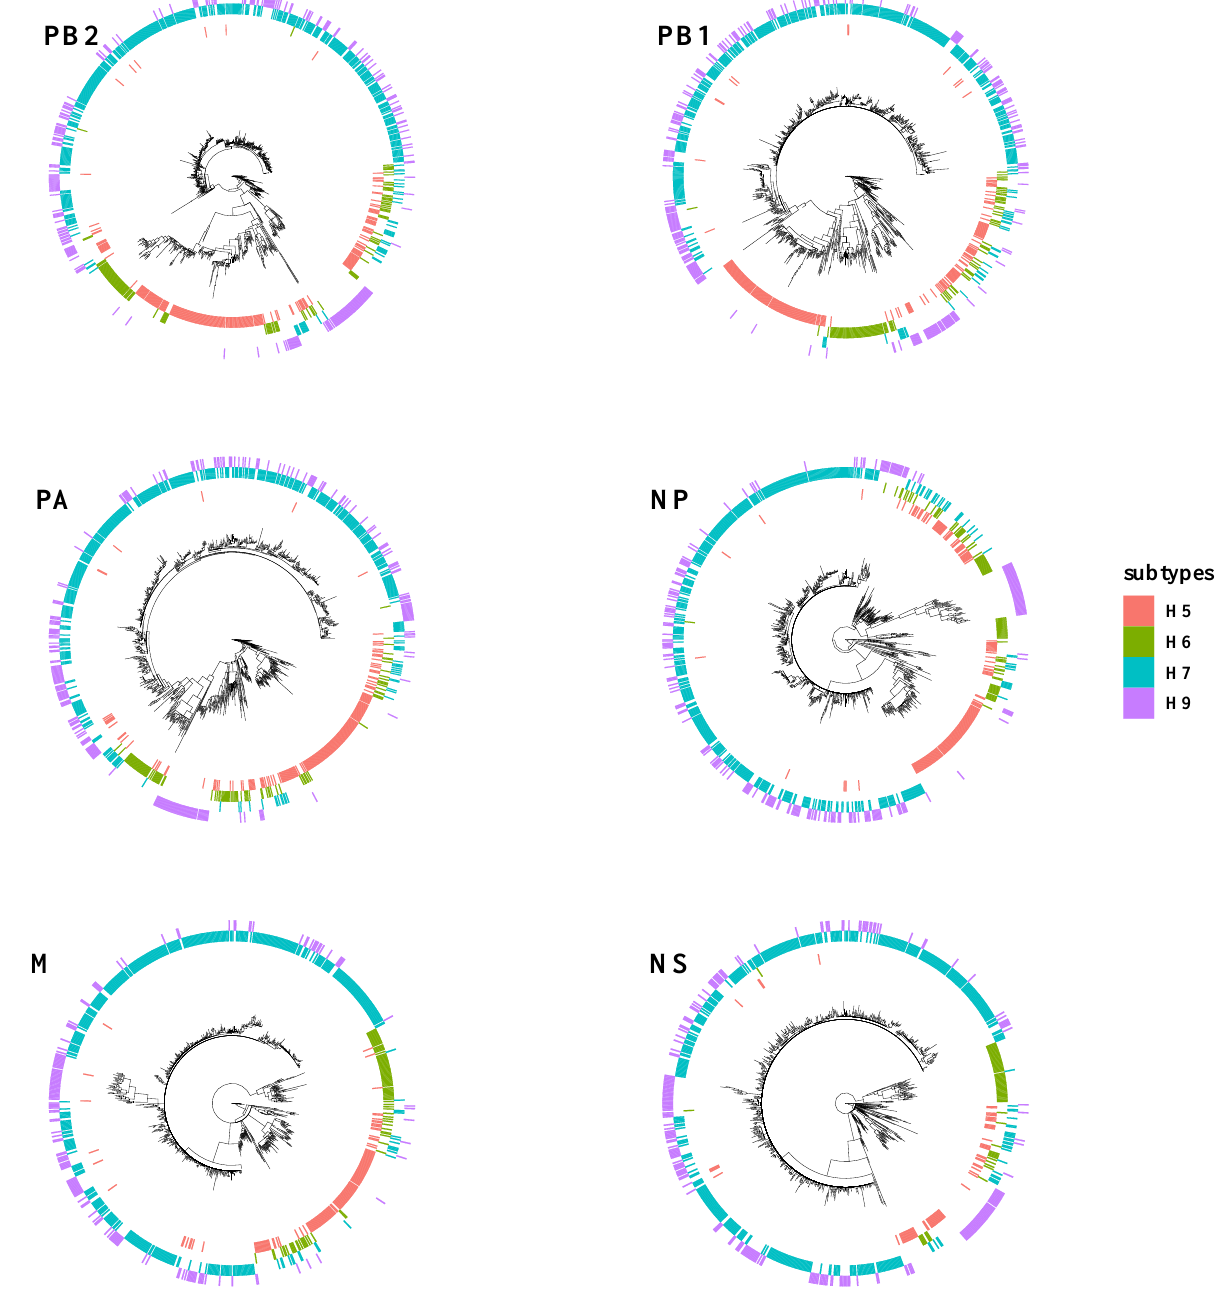
Figure 4. Intersubtype reassortment between H7N9 and H5, H6, and H9 subtypes of avian influenza 254 viruses.